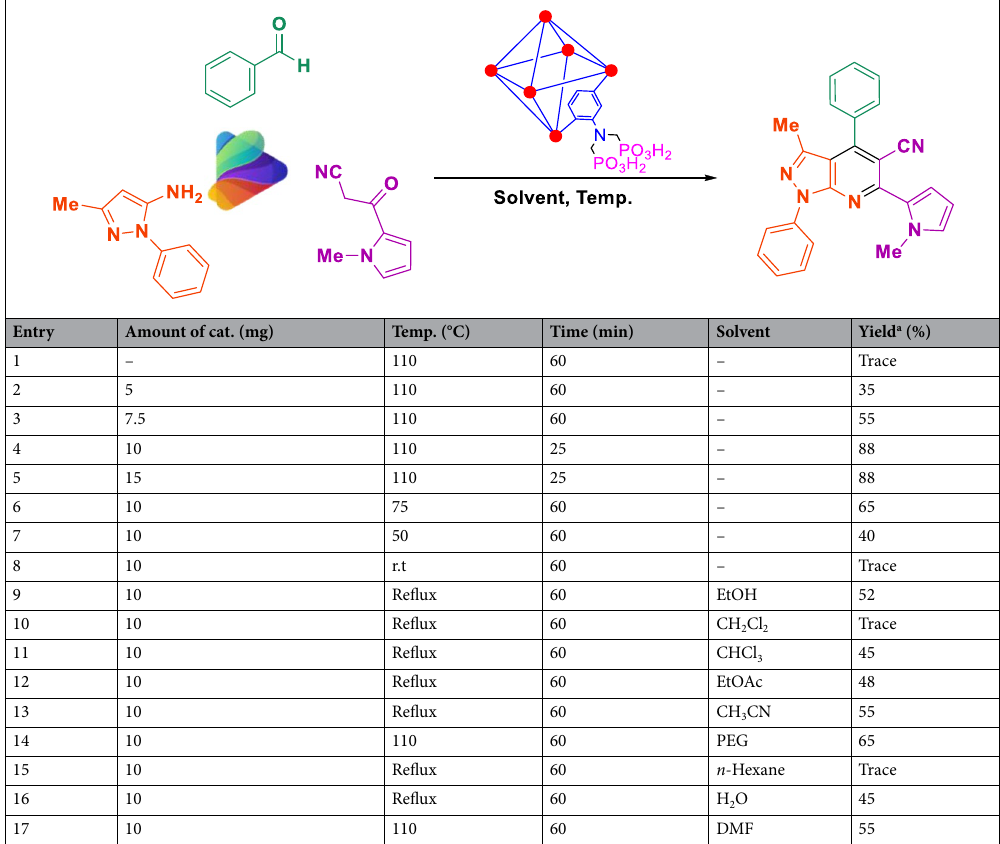
appropriate for the preparation of target molecules in high to excellent yields (65–92%) within relatively short reaction times (20–40 min). Interestingly, when we synthesized ( N -methyl-pyrrol)-pyrazolo[3,4- b ]pyridines in the percent indole aldehyde as a biological and pharmacological compound (Table 2). Also, the preparation of bis and tris-( N -methyl-pyrrol)-pyrazolo[3,4- b ]pyridines by the condensation of 3-methyl-1-phenyl-1 H -pyrazol-5- In suggested mechanism, aldehyde is activated with PO 3 H 2 tags of MIL-53(Al)-N(CH 2 PO 3 H 2 ) 2 and intermedi- ate (I) is prepared by reaction of 3-(1-methyl-1 H -pyrrol-2-yl)-3-oxopropanenitrile with the loss of H 2 O. In the second step, phenyl pyrazol-5-amine react with intermediate (I) to gives intermediate (II) after tautomerization. Then, intermediate (II) gives intermediates (III) after intramolecular cyclization and loss of one molecule of H 2 O. Then, the corresponding product (IV) is produced via a cooperative vinylogous anomeric based oxida- tion mechanism both in the presence and absence of oxygen (pathways A and B in Fig. 14) 62,63,67,68,79 . It should be mentioned that the reaction in the absence of oxygen and under both nitrogen and argon atmospheres have proceeded as same as in the presence of oxygen. Recently, we have comprehensively showed that the hetero atoms have stereoelectronic effects of common origin and that anomeric effect is one of them 80 . To evaluate the performance of MIL-53(Al)-N(CH 2 PO 3 H 2 ) 2 as a catalyst for the synthesis of ( N -methyl- pyrrol)-pyrazolo[3,4- b ]pyridines, we have tested various acid catalysts (organic and inorganic) in the reac- are collected in Table 4 shows that, MIL-53(Al)-N(CH 2 PO 3 H 2 ) 2 is the best catalyst for the synthesis of a novel ( N -methyl-pyrrol)-pyrazolo[3,4- b ]pyridines. The obtained results of catalytic activity and reusability of MIL-53(Al)-N(CH 2 PO 3 H 2 ) 2 were added in (Fig. 15). As above said, MIL-53(Al)-N(CH 2 PO 3 H 2 ) 2 was separated by centrifugation and reused without sig- nificantly reducing its catalytic activity. For this purpose, recyclability of the catalyst was also studied on the one-pot reaction of benzaldehyde (1.0 mmol, 0.106 g), 3-methyl-1-phenyl-1 H -pyrazol-5-amine (1.0